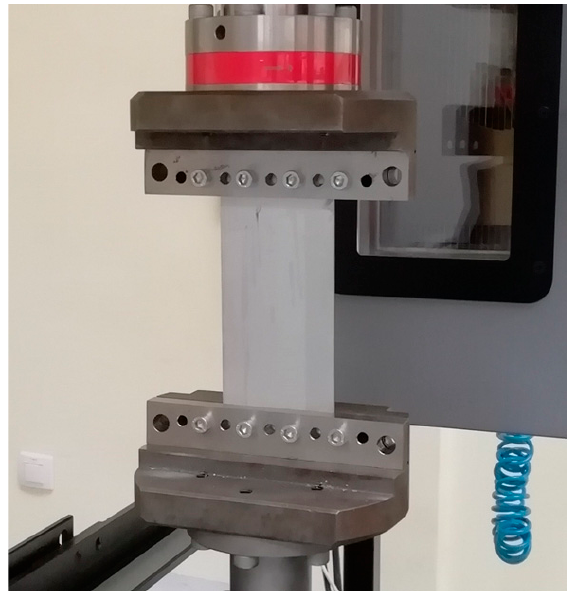
Figure 10. Equipment for the buckling experiment.